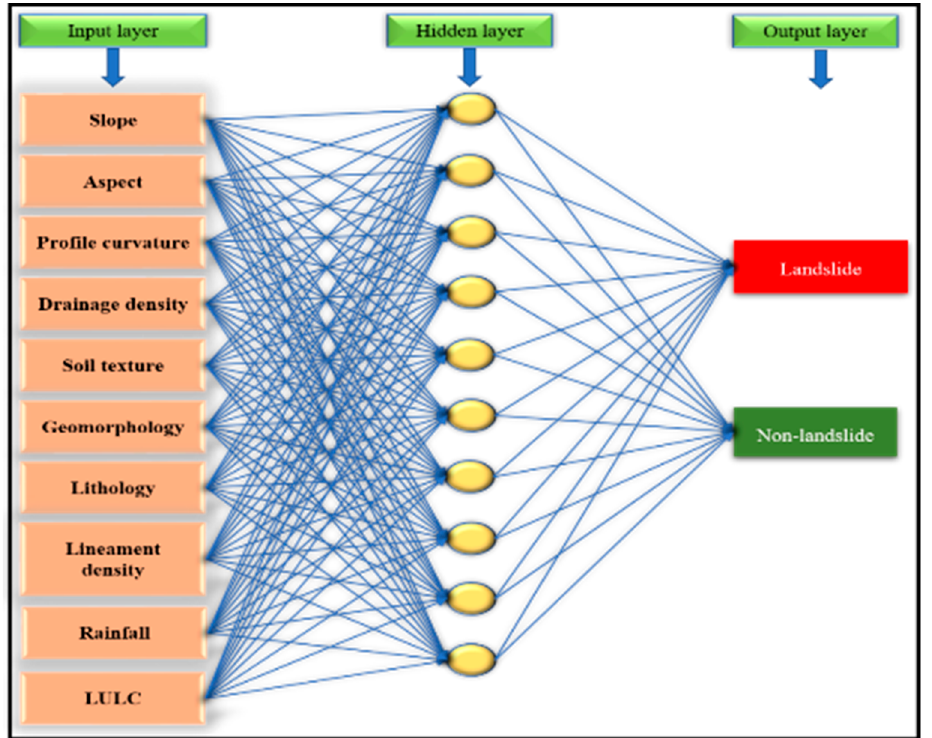
Figure 5. The basic structure of ANN.